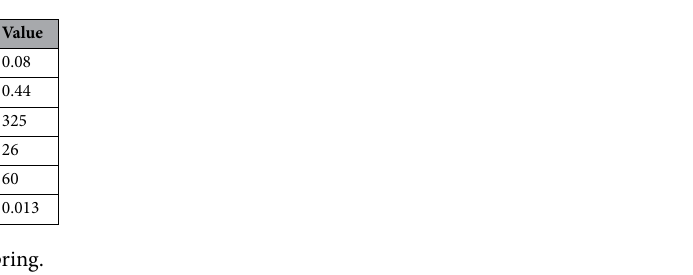
Table 1. Specification of SMA